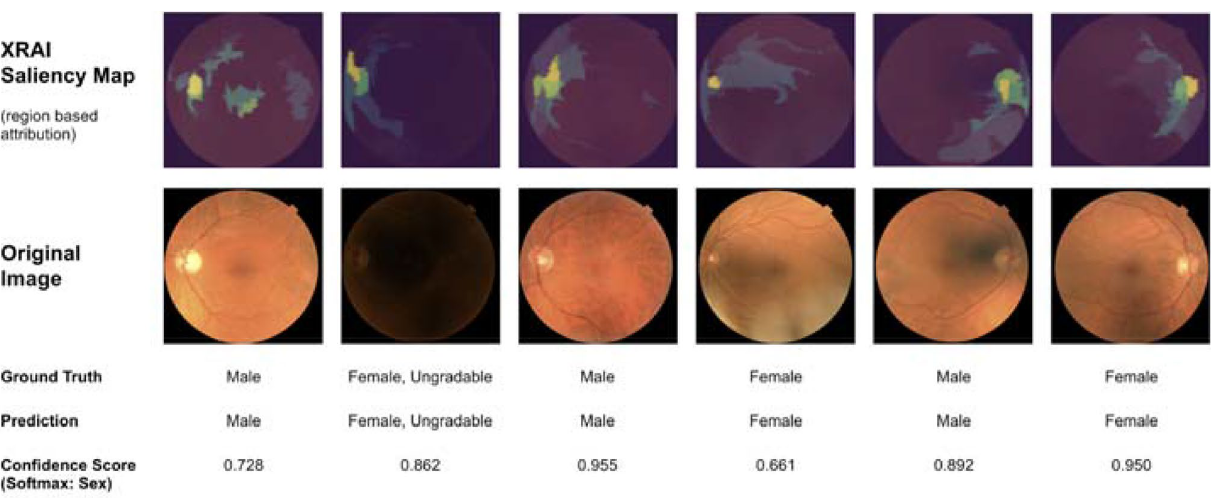
Figure 2. Region based saliency maps for model prediction: colors represent regions in order of decreasing performance: Yellow, Green, Blue. Images sourced at random from validation set, with the addition of an ungradable